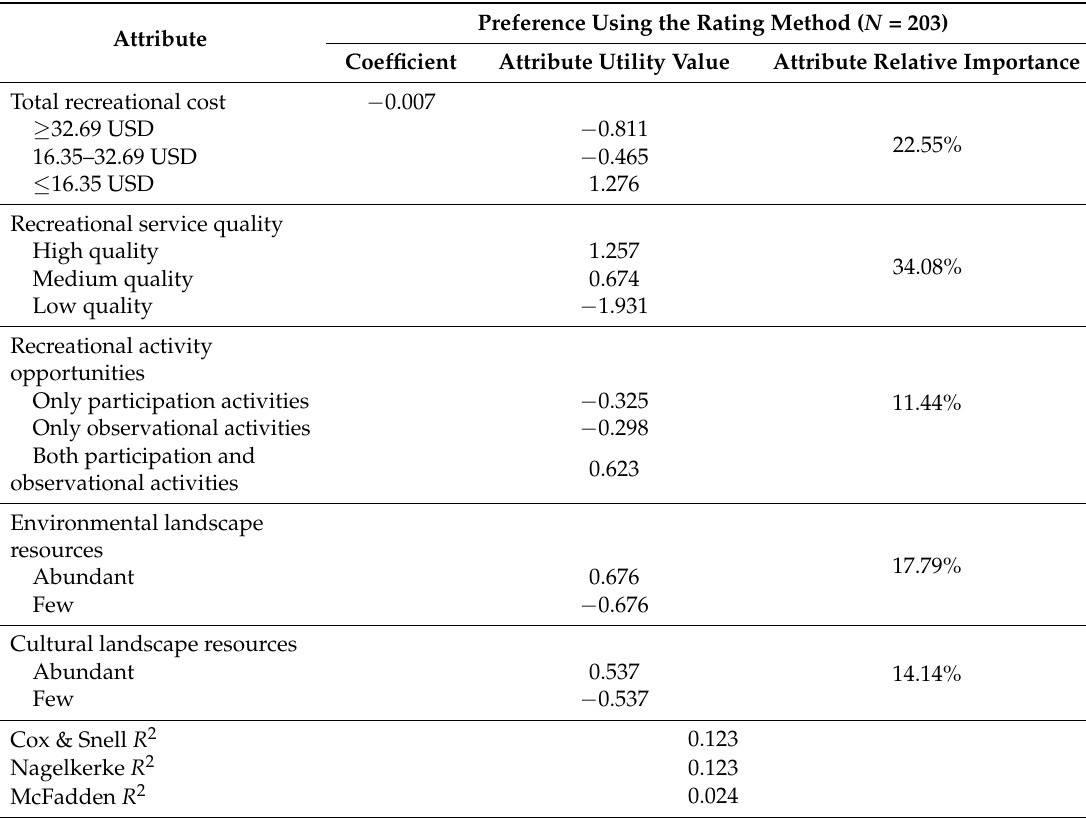
Table 6. Evaluation results for the Calligraphy Greenway using the rating